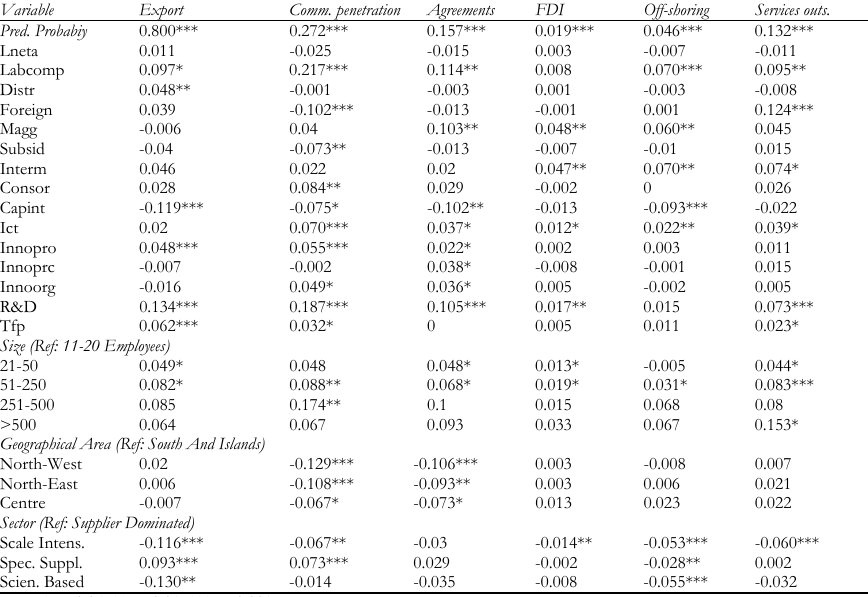
Estimated marginal effects on marginal probabilities